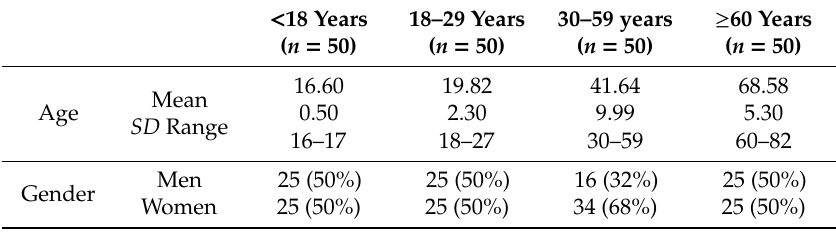
Table 1. Participant’s